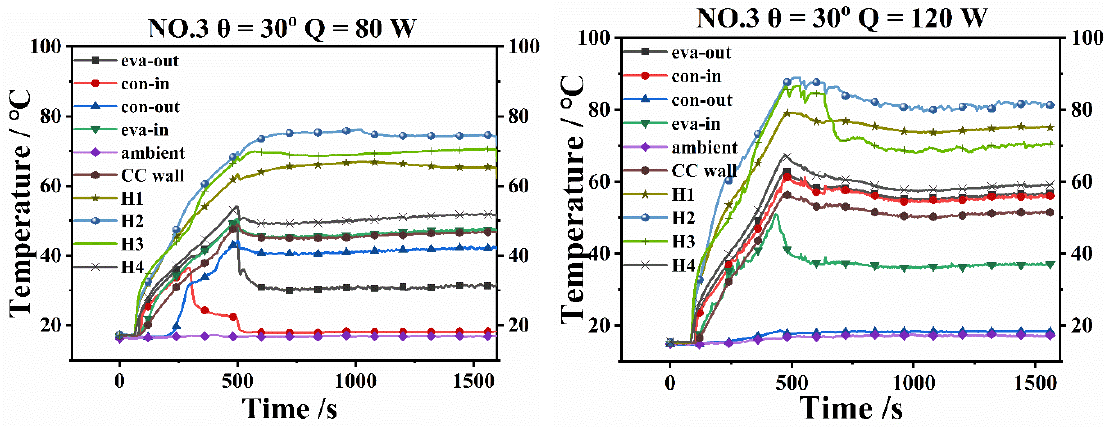
Figure 10. Temperature response during start up process of No.3 position at 80 W and 120 W.